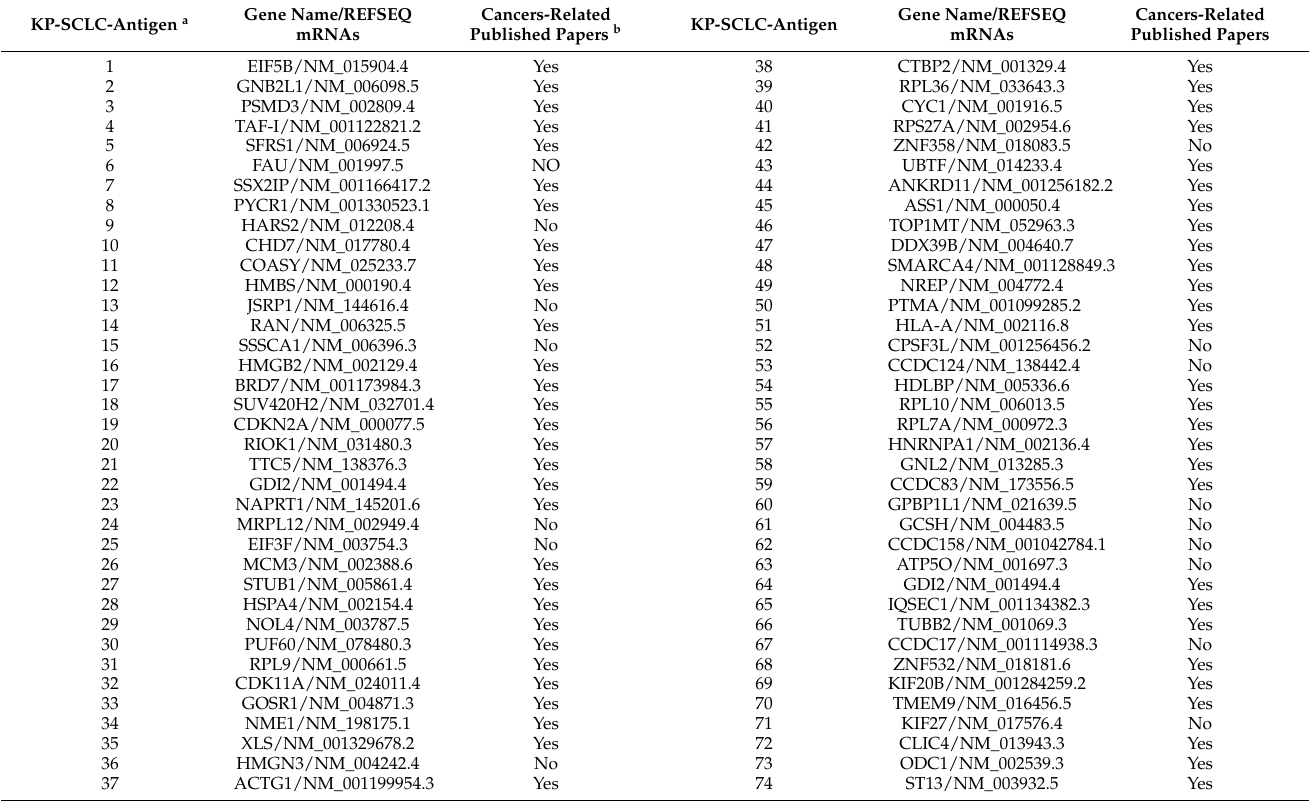
Table 1. Antigens identified by SEREX in SCLC